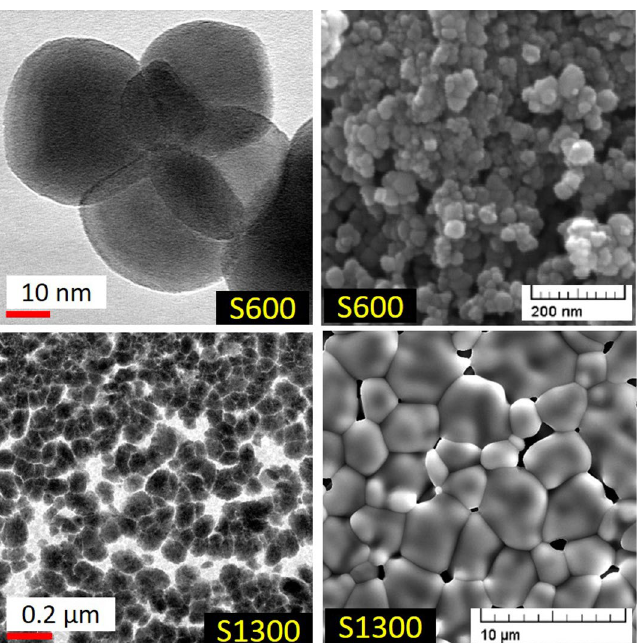
Figure 1. TEM (left column) and SEM (right column) images of pristine S600 and S1300. Adapted from Ref. 21